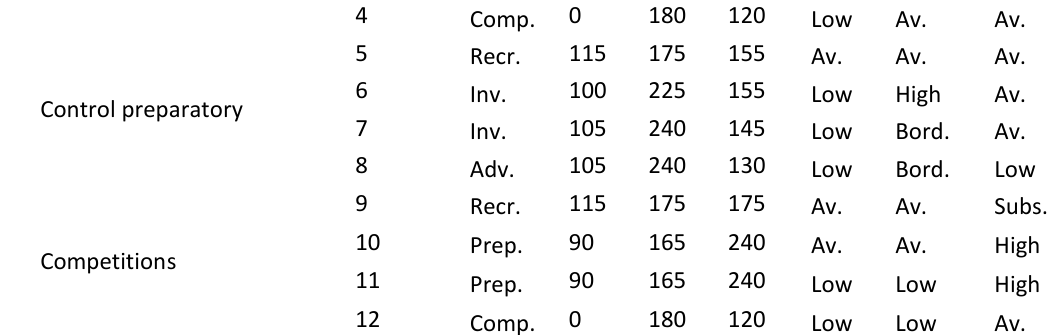
QBL, shaping basic, kg shaping, kg